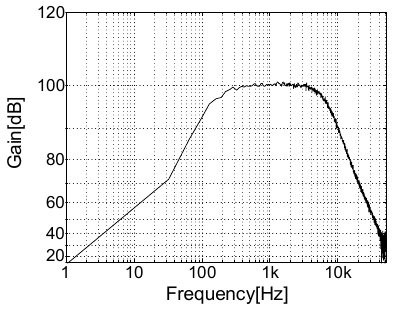
Figure 11. Frequency response of the overall amplifier system.